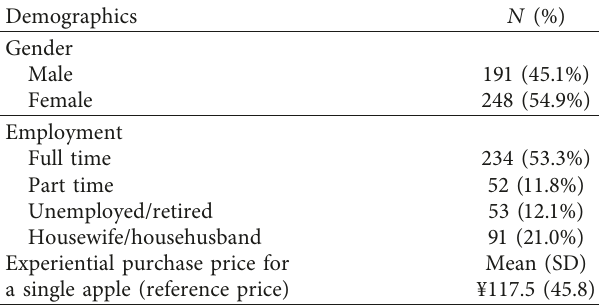
Table 1: Participant